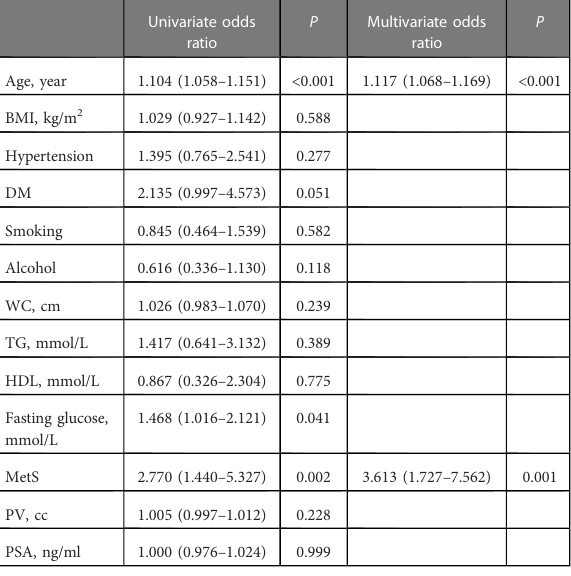
TABLE 3 Univariate and multivariate binary logistic regression to predict the risk of improvement in nocturia after